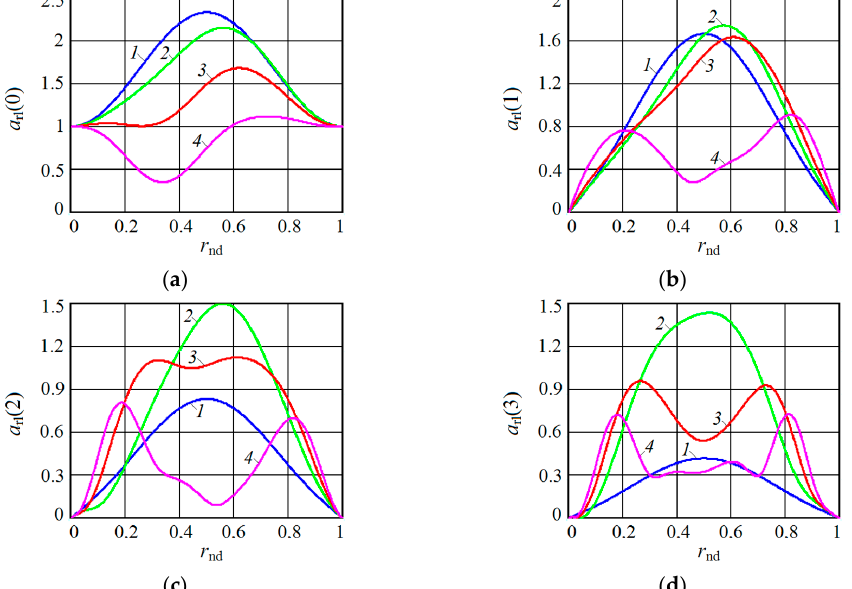
r Figure 5. Plots of CAS section along the axis r ( 0 ) , ( b ) first a ( 1 ) , ( c ) second a ( 2 ) nd on the ( a ) zero a rl rl rl nd